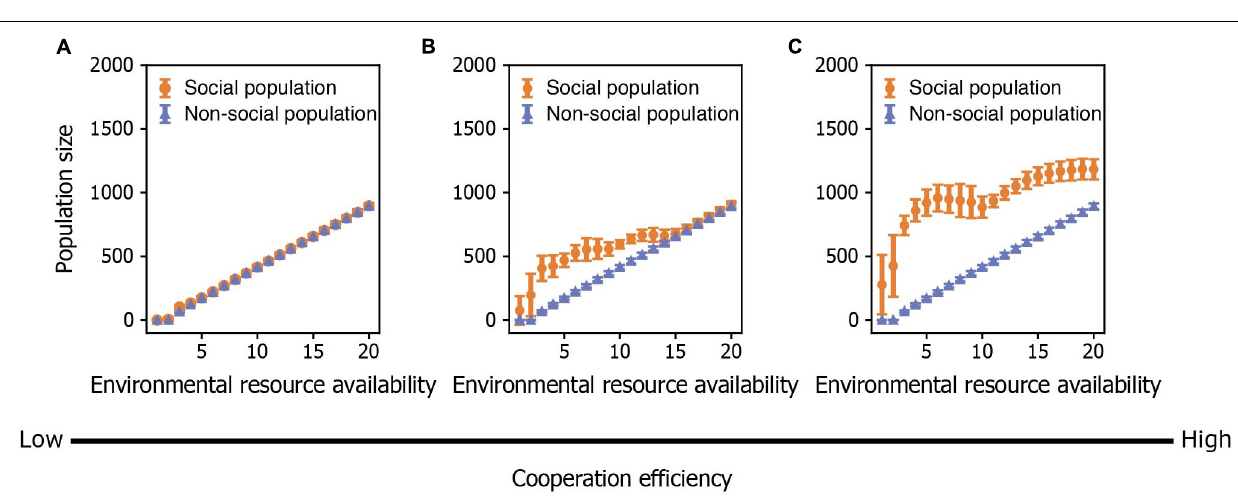
FIGURE 5 | The combined effects of environmental resource availability and the degree of cooperation on population size. (A–C) Population size in relation to environmental resource availability when cooperation efficiency is (A) low ( b K = 1), (B) medium ( b K = 3), and (C) high ( b K = 5). Points represent means and bars represent standard deviations. Each mean and standard deviation is calculated on the output data of 500